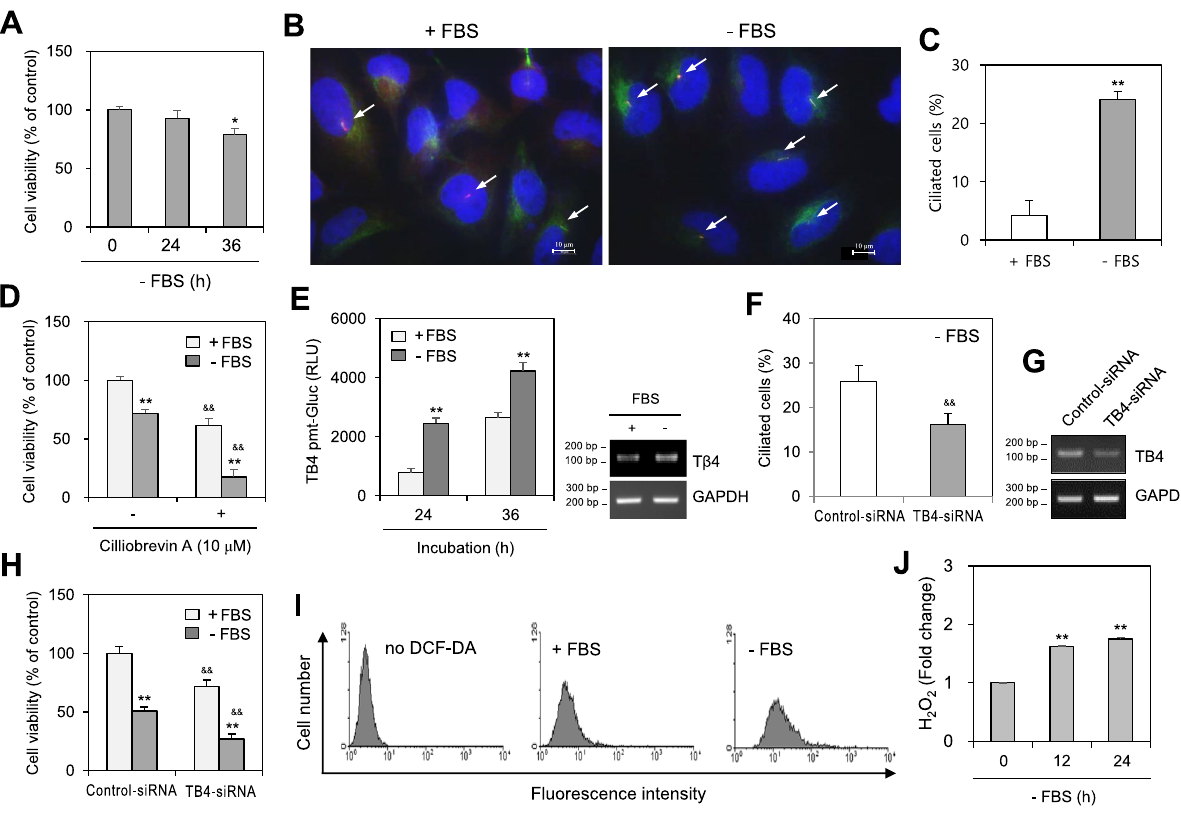
Figure 1. Serum-deprivation without fetal bovine serum (-FBS) affected cell viability, primary cilia formation, the expression of thymosin beta-4 and reactive oxygen species production. ( A – C ) HeLa cells were incubated in serum-deprived media without FBS. Cell viability was measured by MTT assay ( A ). The cells were fixed and stained with antibody against Ac-tubulin (green) and Arl13b (red). Nucleus was stained with DAPI (blue). The representative image of primary cilia was observed with 1000X magnification under fluorescence microscope. White arrows indicated primary cilia ( B ). The ciliated HeLa cells out of more than 1,000 cells in the presence (white) or absence (grey) of FBS were counted. PC frequency was evaluated by the blinded double scoring ( C ). ( D ) The cells were incubated in the presence or absence of ciliobrevin A under serum- deprived condition for 36 h. Cell viability was measured by MTT assay. ( E ) HeLa cells were transfected with pEZX-PG02-TB4-promoter Gaussia luciferase (Gluc) plasmid and incubated for up to 36 h. The activity of Gluc in cultured media was measured with luminometer using Gluc substrate (E, left). Expression level of TB4 was measured by RT-PCR (E, right). ( F – H ) Cells were transfected with AccuTarget negative control-siRNA or TB4-siRNA for 24 h. The cells were fixed and stained with antibody against Ac-tubulin (green) and Arl13b (red). Nucleus was stained with DAPI (blue). The ciliated cells out of more than 1000 cells in the presence (white) or absence (grey) of FBS were counted. PC frequency was evaluated by the blinded double scoring ( F ). The mRNA expression of TB4 was detected by RT-PCR ( G ). Cell viability was measured by CellTiter Glo assay ( H ). ( I , J ) Cells were incubated under serum-deprived condition for up to 24 h. Cells were treated with DCF-DA and ROS production was measured by FACS analysis ( I ). H 2 O 2 production was measured with the changes in fluorescence of scopoletin ( J ). Each result was the representative of experiments performed at least four times and each experiment was performed with four samples (n = 4) in the same group. Data in bar graphs represents the means ± SD. * p < 0.05, ** p < 0.01; significantly different from 5% FBS-treated ( A , C – E , H ) or 0% FBS-untreated ( J ) control group. && p < 0.01; significantly different from ciliobrevin A-untreated group ( D ) or control-siRNA-treated ( F , H ) group with either 5% or 0%